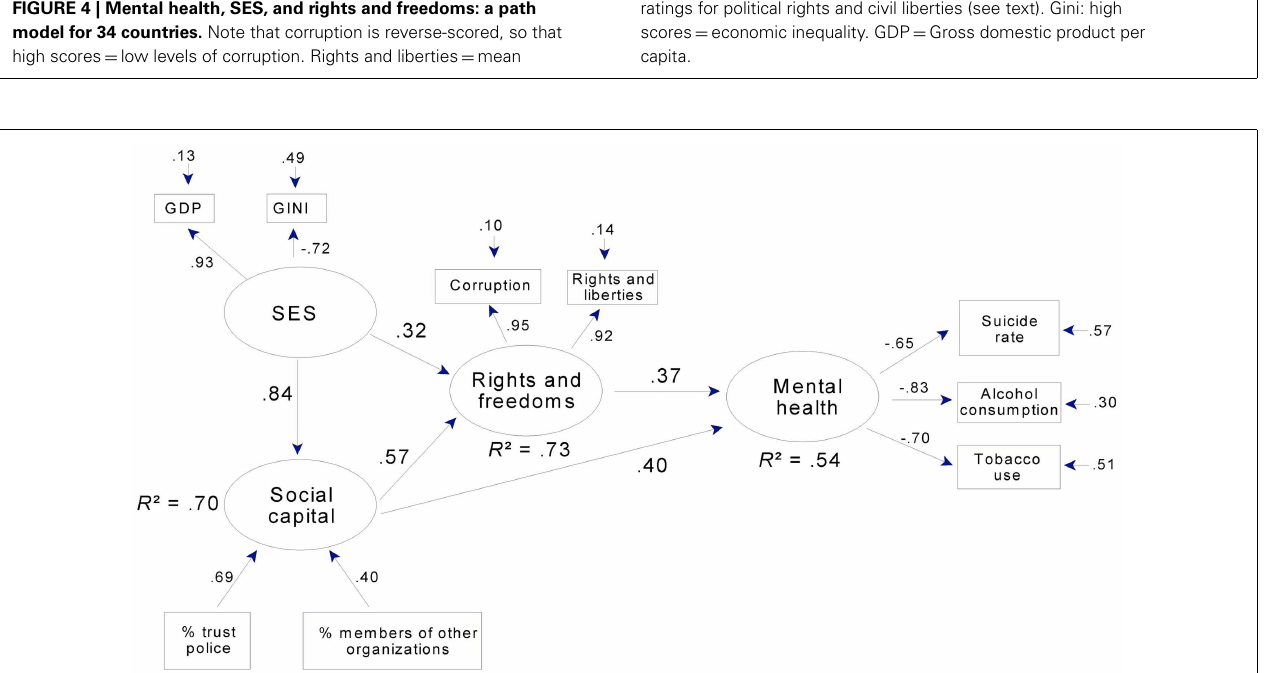
FIGURE 5 | Mental health, social capital, SES, and rights and freedoms: a path model for 23 countries. Note that corruption is reverse-scored, so that high scores = low levels of corruption. Rights and liberties = mean ratings for political rights and civil liberties (see text). Gini: high scores = economic